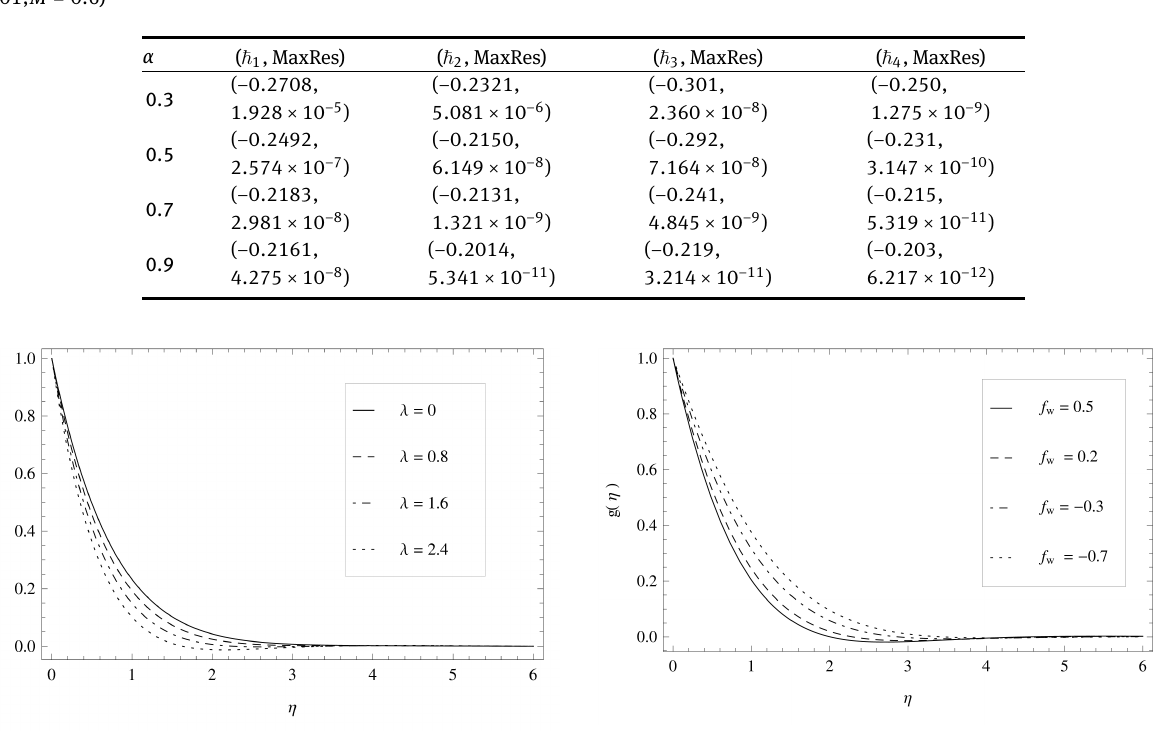
Table 4: The values of optimal (cid:126) 1 , (cid:126) 2 , (cid:126) 3 , (cid:126) 4 and maximum residual errors (MaxRes) at various values of α ( We = 0.04, λ = 0.04, f w = 0.01, M = 0.6 )